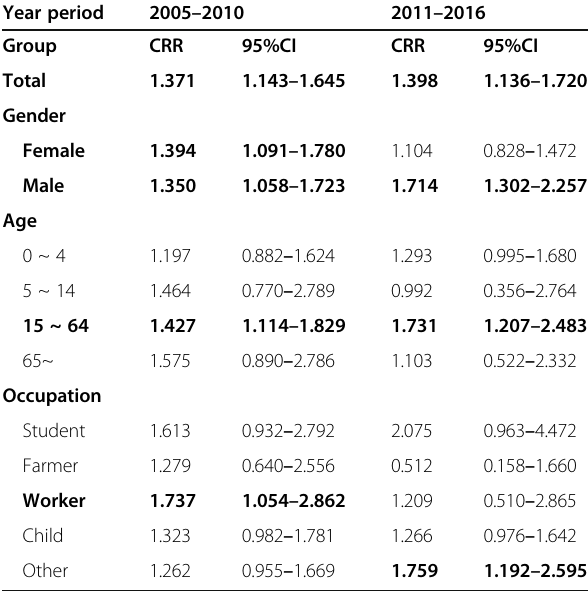
Table 3 The cumulative relative risk of floods to